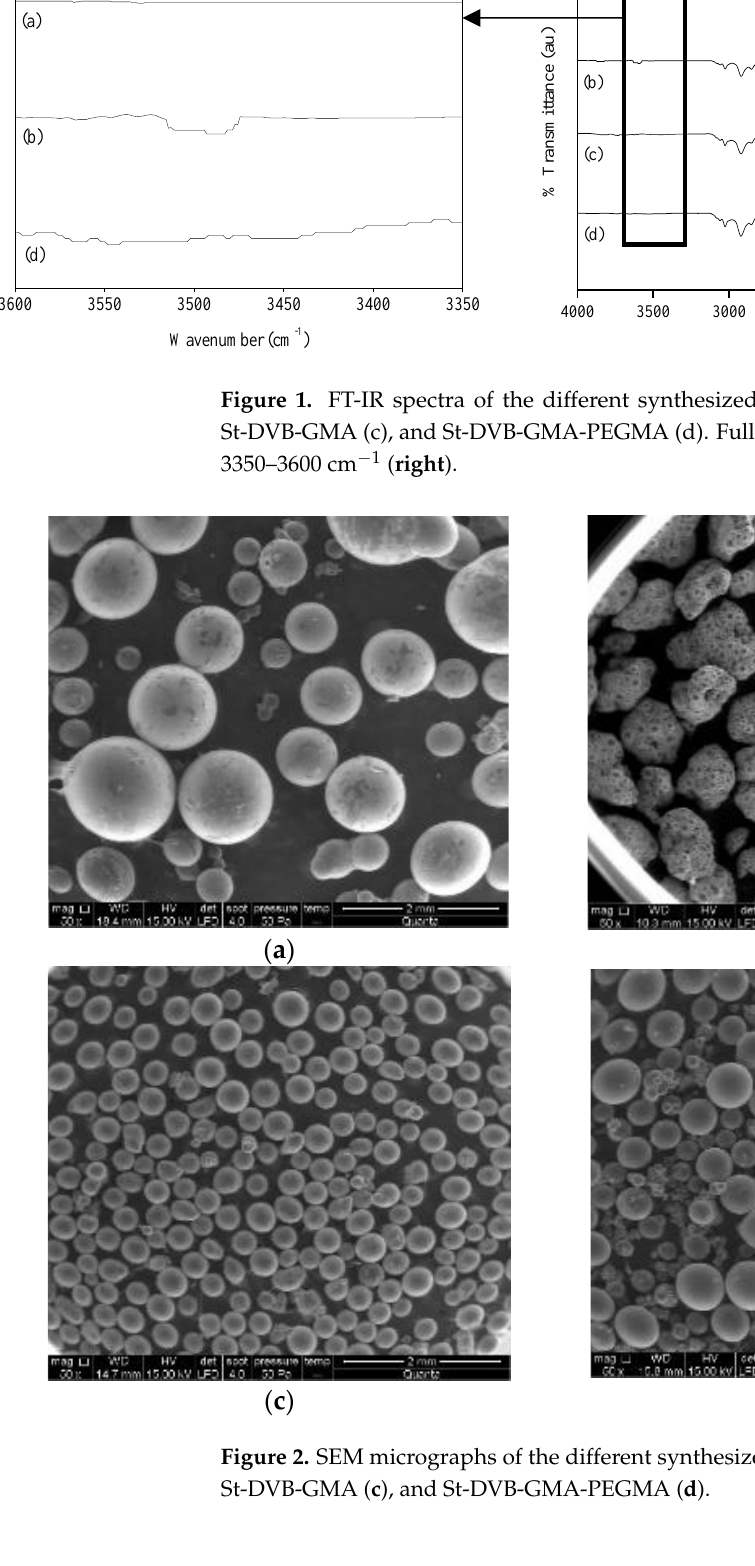
( d ) Figure 2. SEM micrographs of the different synthesized particles: St-DVB ( a ), St-DVB-PEGMA ( b ), St-DVB-GMA ( c ), and St-DVB-GMA-PEGMA ( d ).